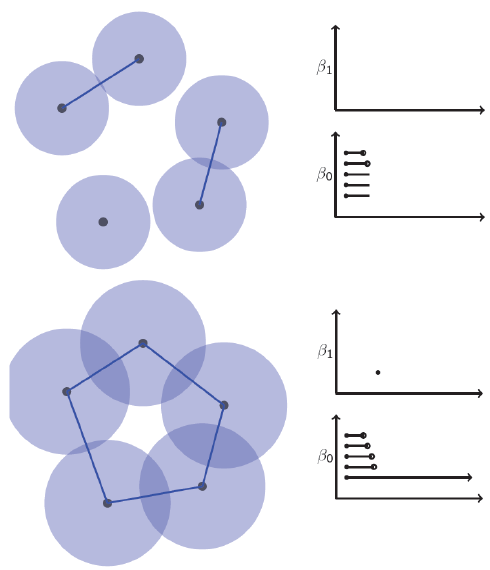
Figure 1: The filtration with the help of Cech covering. At the top, 5 are the connected components that has been decreased to the three due to creating the edges. The barcodes for Betti numbers show three open line segment and two closed ones. In the bot- tom, one connected component has been left and one barcode that corresponds to it. The "hole" has been born and the barcode has appeared for Betti